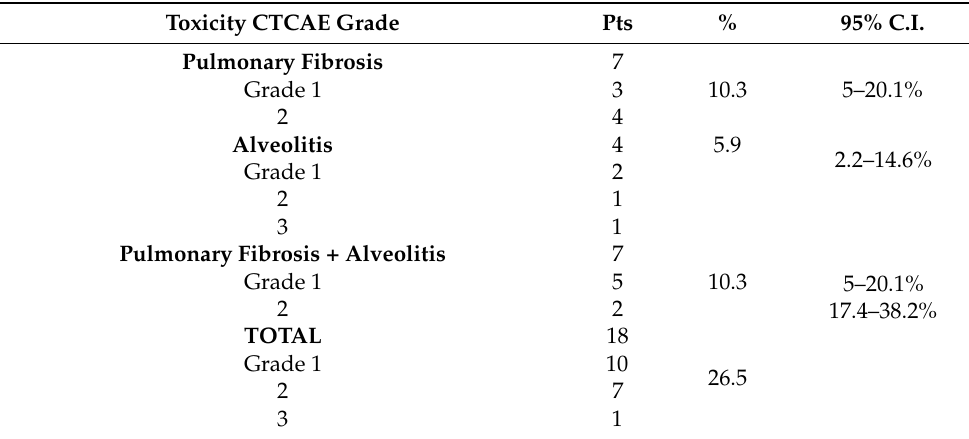
Table 3. Radiological toxicity—incidence and grade in 68 patients.